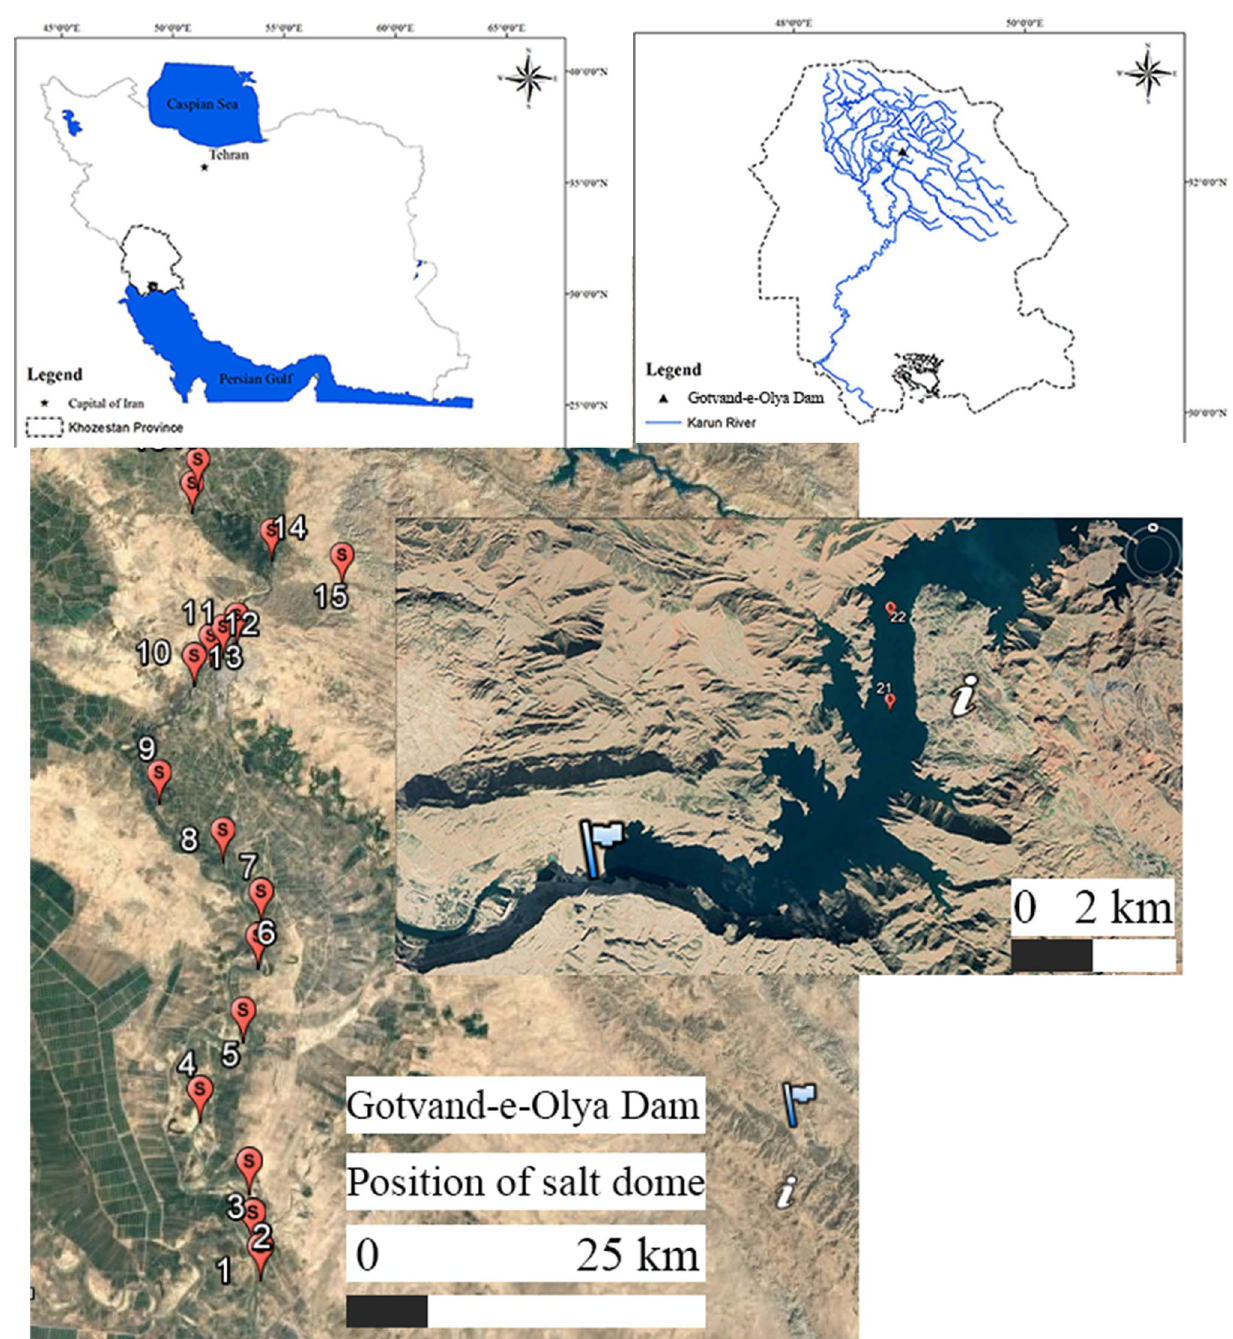
Fig. 1 Location of sampling stations including five stations in the lake and 20 stations in downstream of the Gotvand-e-Olya